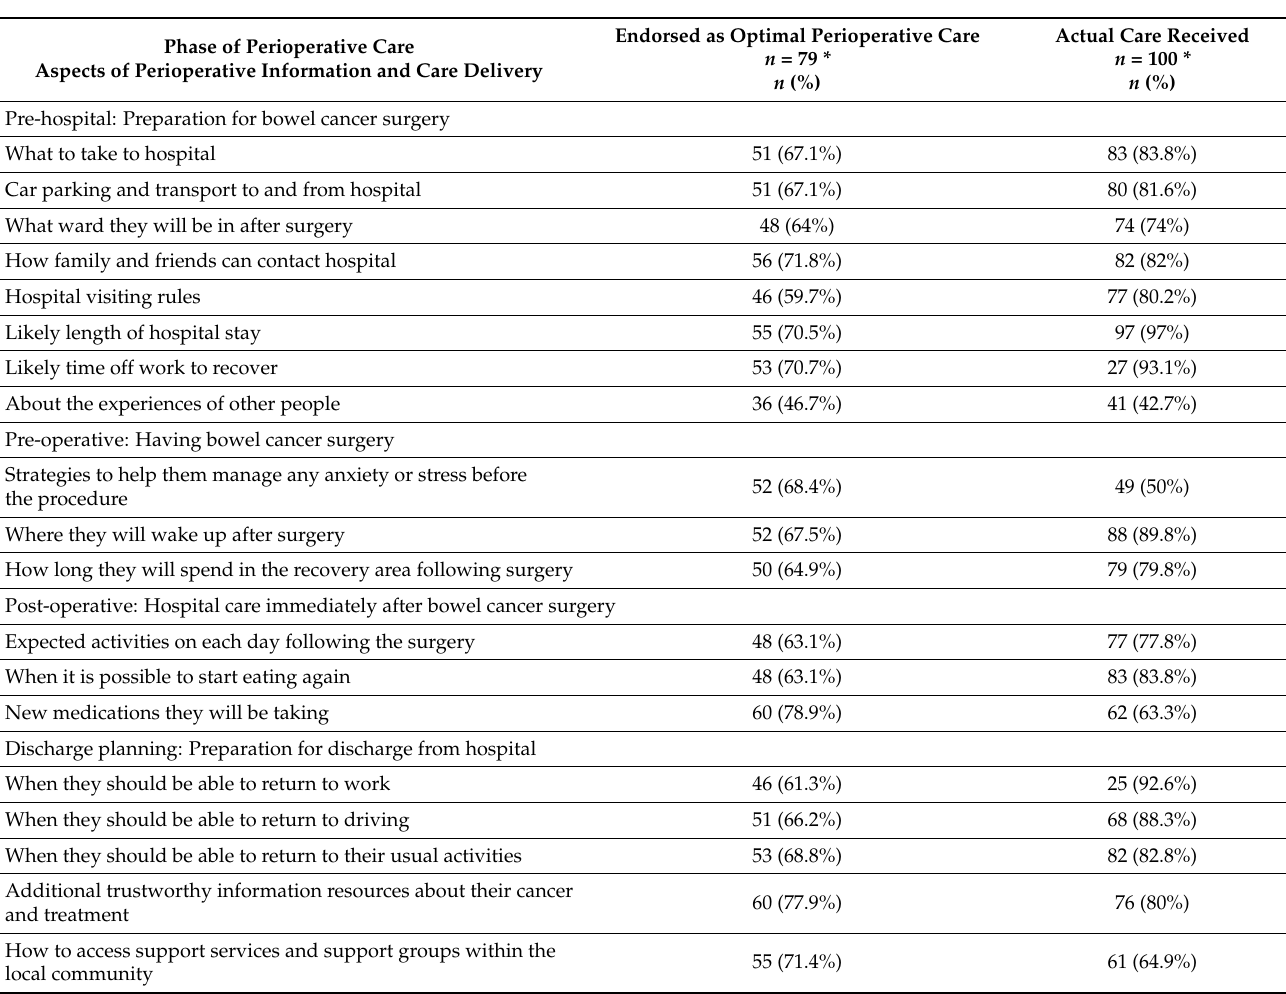
Table 4. Aspects of perioperative information and care endorsed ‘optimal’ by fewer than 80% of patients ( n = 23